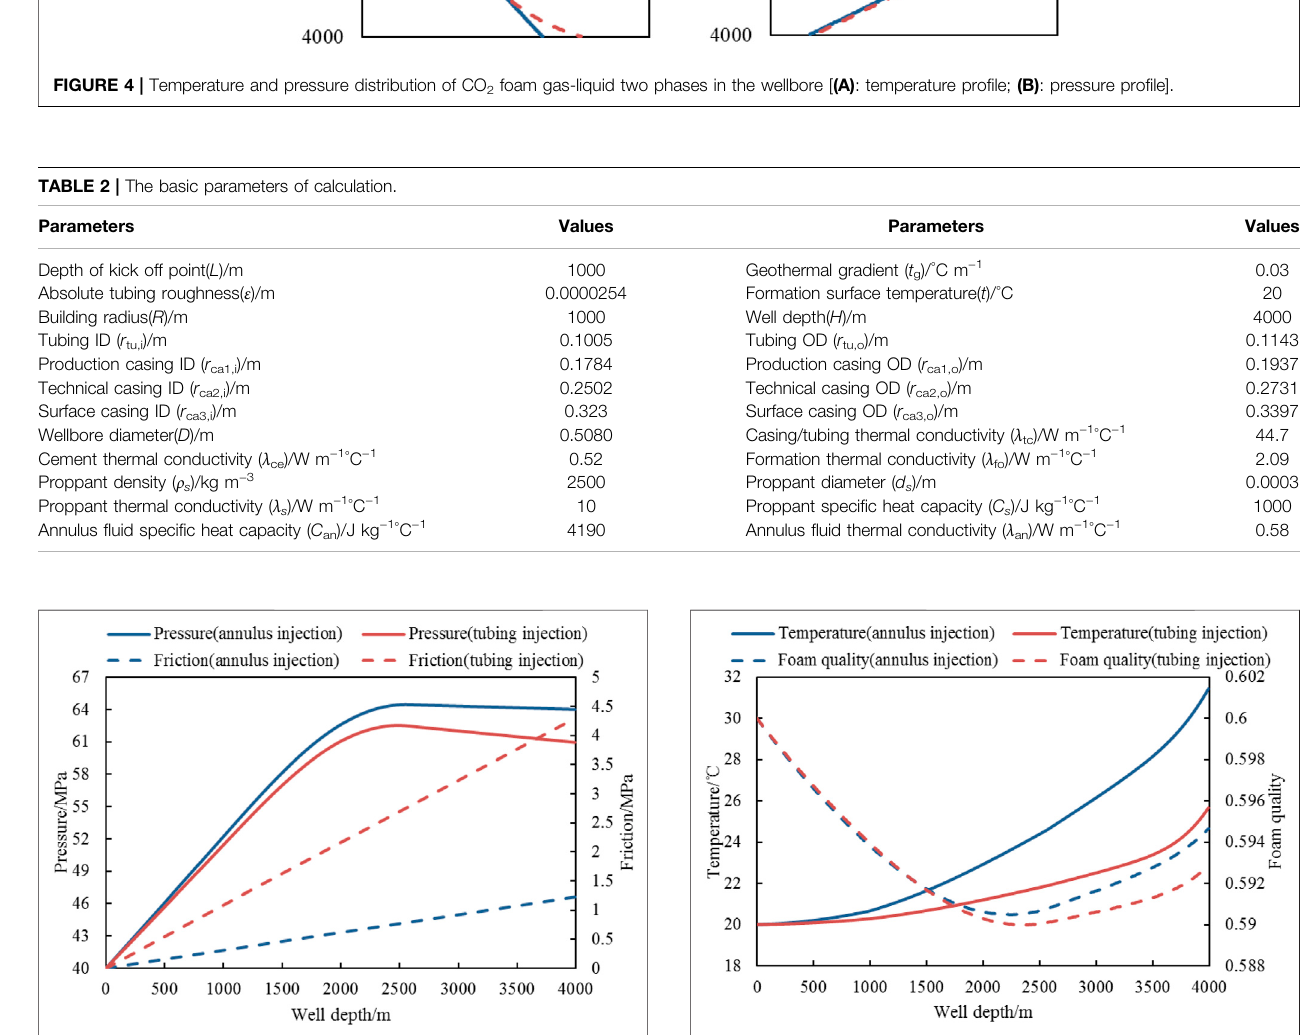
FIGURE 5 | Changes of pressure and friction under different injection methods.